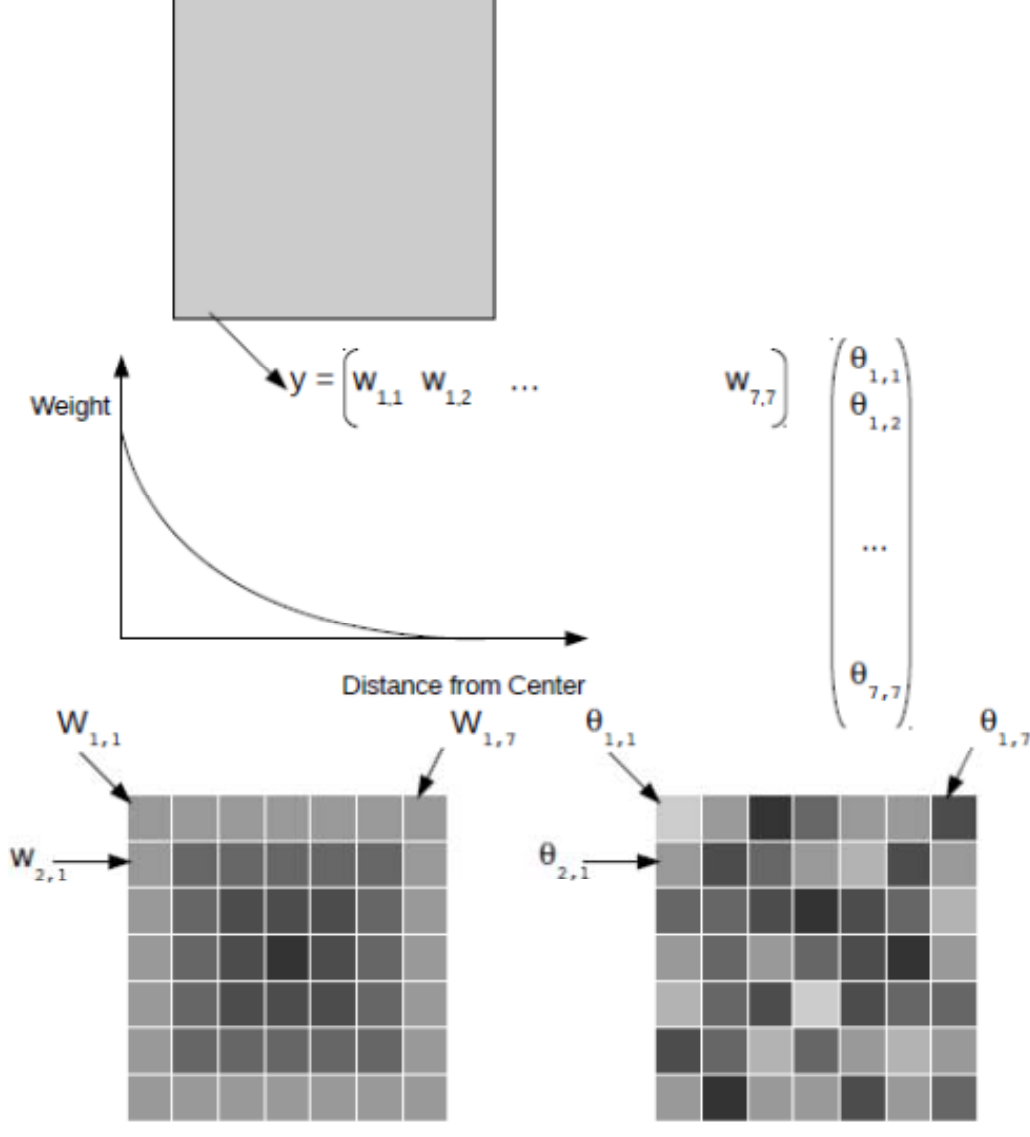
Figure 3. Schematic of the use of the observation operator for the assimilation of coarse-scale data into a fine-resolution 2D model. w stands for the weight of the model (cid:2919),(cid:2920) result in row i and column j in the calculation of the grid-averaged model result. Darker colors represent higher weights. θ stands for the model results, and darker values represent higher values. For simplicity, the . (cid:2879) is omitted from the y and θ variables, and the time index k is omitted from all